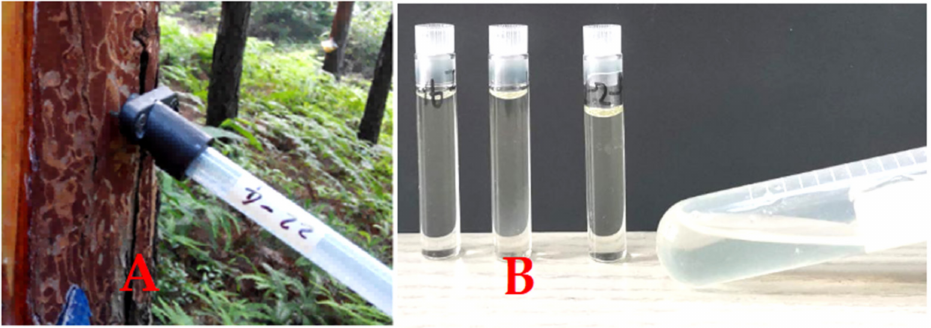
Figure 1. Resin collection ( A ) and NIR scan ( B )